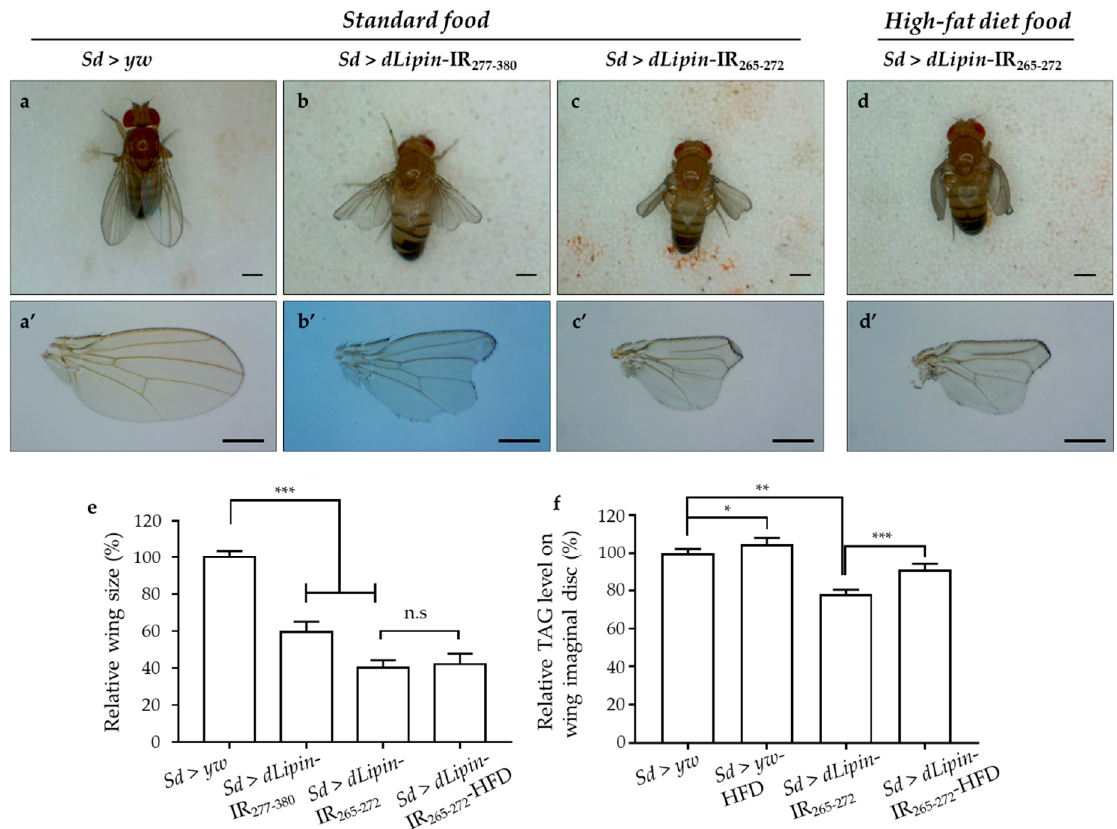
Figure 2. dLipin -kd selectively causes atrophied wing development in the wing imaginal disc. Micrographs of adult flies ( a – d ) and wing blades ( a’ – d’ ) are shown. The control flies were obtained by crossing the Sd -GAL4 drivers with the yw strain ( a , a’ ). Wings of dLipin -kd flies ( Sd > dLipin -IR 265-272 and Sd > dLipin -IR 277-380 ) showed wing notching and curl ( b , b’ , c , c’ ). dLipin -kd phenotypes were not recused by the administration of a high-fat diet ( d , d’ ). The size of the wing blade was analyzed using ImageJ software. The relative size of the dLipin -kd fly wing to that of control fly are shown ( n = 50 for each genotype) ( e ). The relative triacylglycerol (TAG) level of the dLipin -kd wing imaginal disc to that of the control was analyzed using 100 imaginal discs ( n = 4 for each genotype) ( f ). Data are expressed as the means ± S.D. The statistical significance of the di ff erence between control and dLipin -kd flies was evaluated using t -test and one-way ANOVA. Scale bar, 0.5 mm; *, p = 0.03, **, p < 0.02, ***, p < 0.01; n.s, no significant; IR, inverted repeat, HFD, high-fat diet. Genotypes: Sd -GAL4 / y; + ; + ( a , a’ ), Sd -GAL4 / y; UAS- dLipin -IR 277-380 /+ ; + ( b , b’ ), Sd -GAL4 / y; UAS- dLipin -IR 265-272 /+ ; + ( c , c’ , d , d’